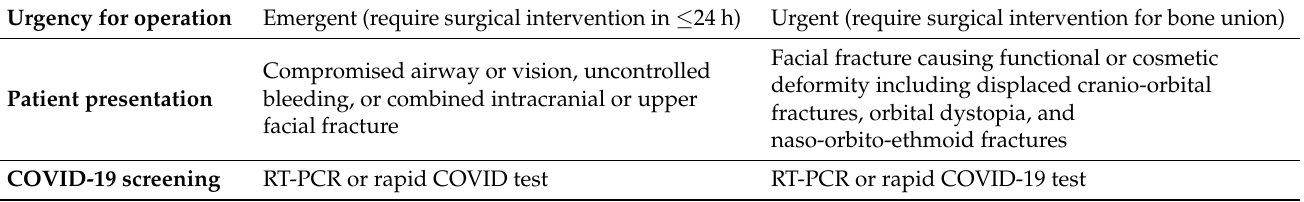
Table 11. International guidelines for management of cranio-maxillo-facial trauma [157]. Urgency for